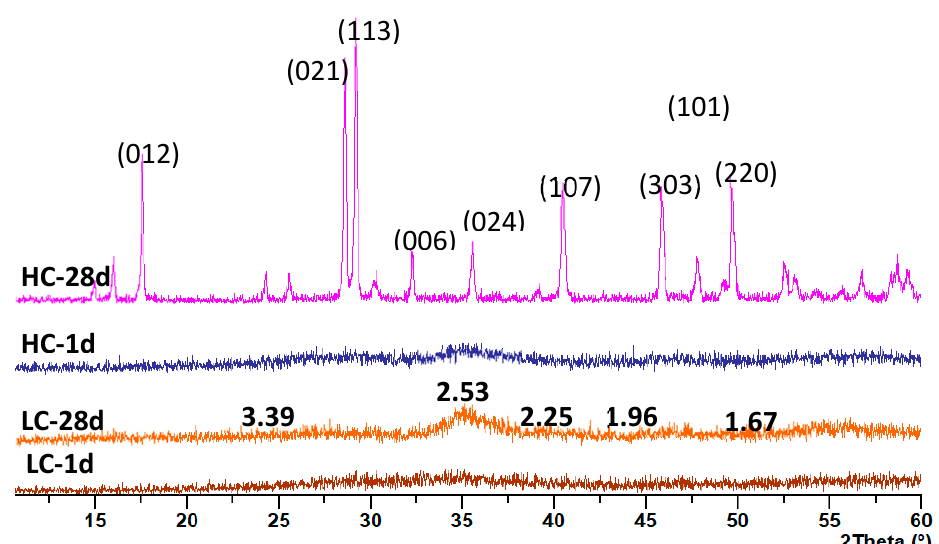
Figure 1. X-ray diffractograms of the solid phases obtained during aging experiments performed with low concentration (LC) and high concentration (HC). Numbers give d-values (Å) for the diffraction peaks of schwertmannite and (hkl) planes are identified for natrojarosite.